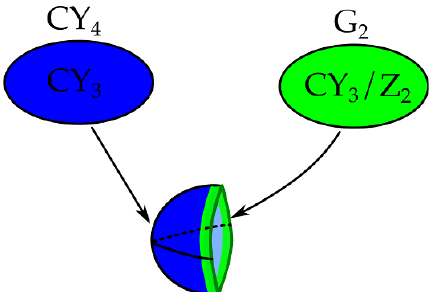
Figure 3 . GCS-construction of Spin(7)-manifolds, from the point of view of a Calabi-Yau four- fold quotient by an anti-holomorphic involution. The CY 4 is as in (1.1) and the picture shows the geometry after the quotient. Away from the boundary circle, which is the (cid:12)xed locus of the involution, we have a CY 3 (cid:12)bered over a disc, which is locally a CY 4 . Above the boundary circle (dark green) the quotient acts non-trivially on the CY 3 (cid:2) interval, shown in light green, which results in a G 2 . Pulling the base apart, results in the GCS-decomposition of the resulting